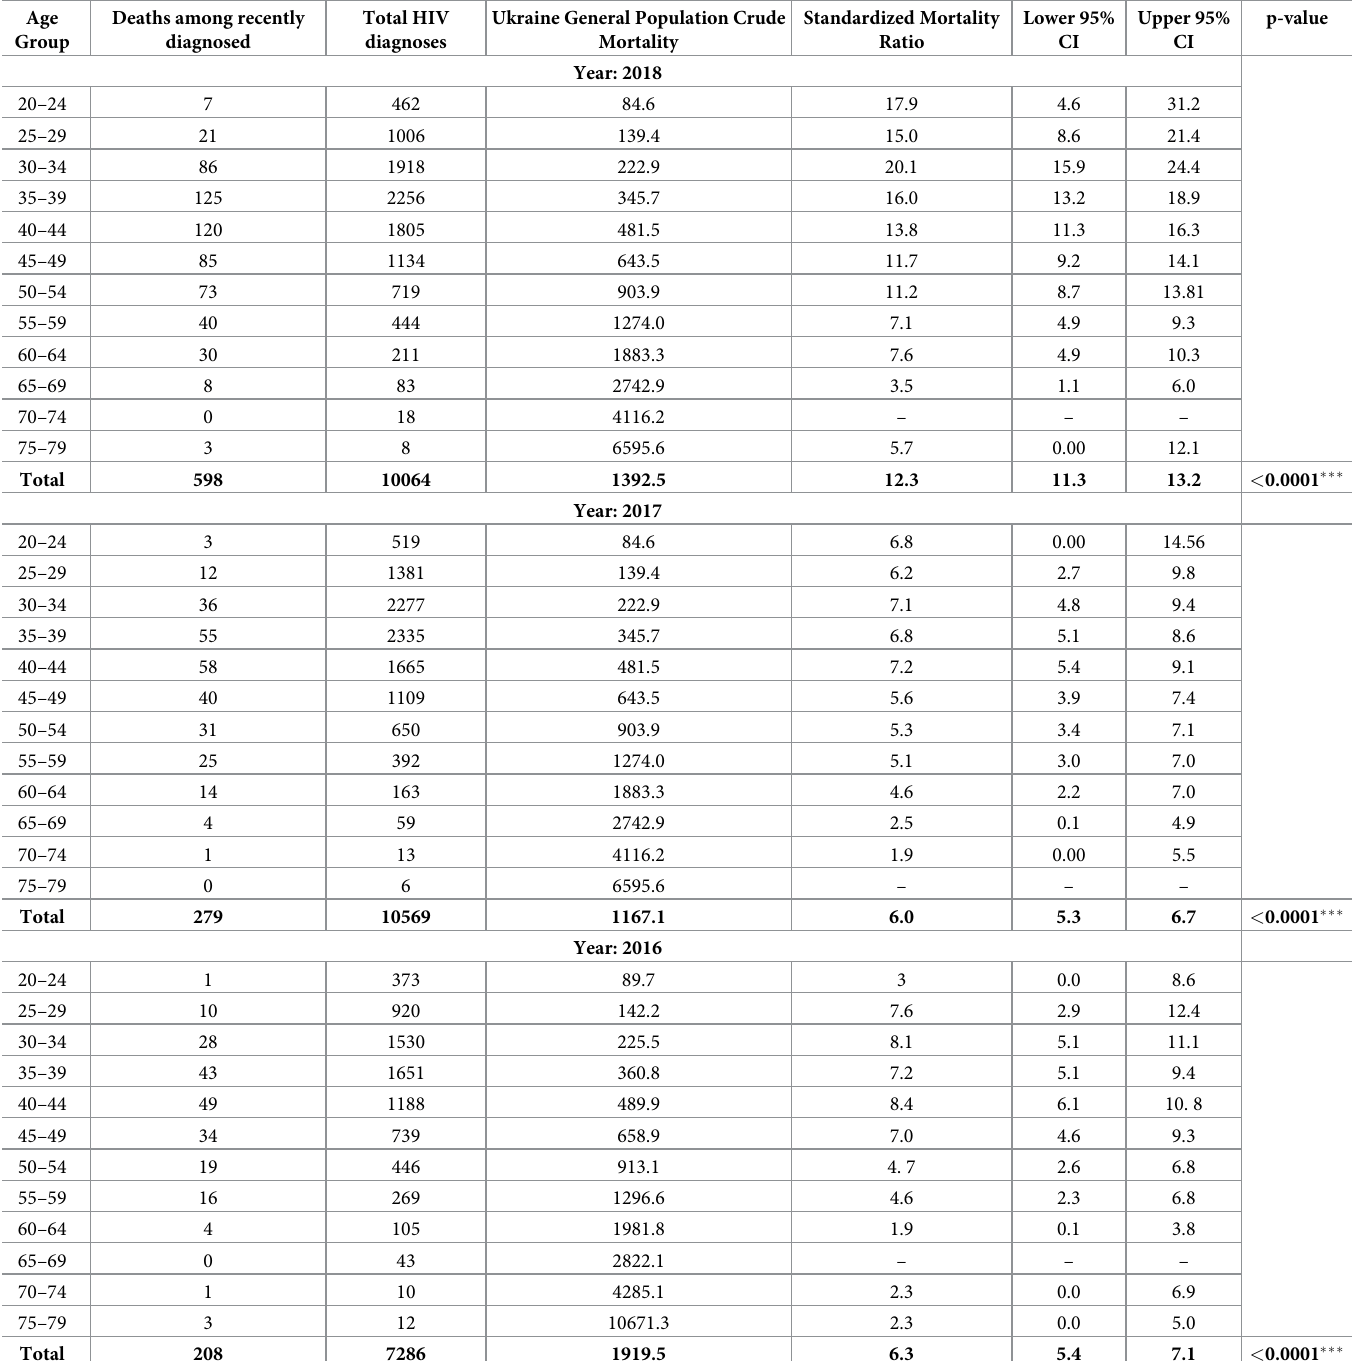
Table 3. Standardized mortality ratios by age strata,